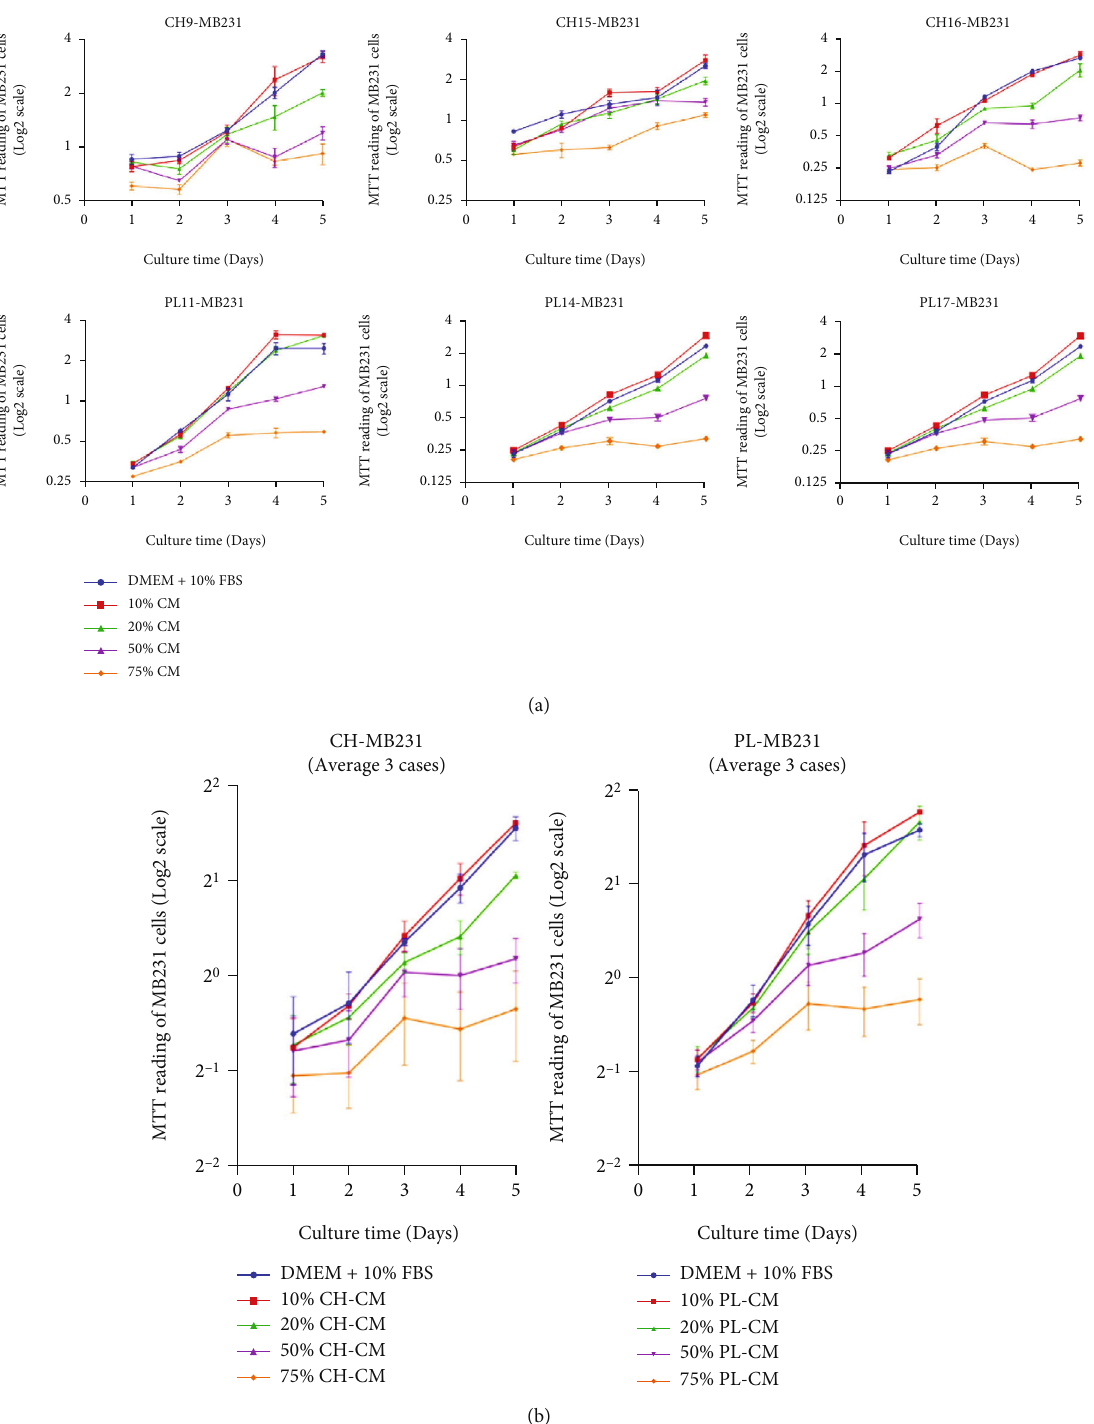
Figure 4: E ff ect of soluble factor derived from CH-hMSCs and PL-hMSCs on the proliferation of human breast cancer MDA-MB231 cells. (a) Graphs show the growth kinetics of MDA-MB231 cells cultured in 10%, 25%, 50%, and 75% conditioned medium derived from CH- hMSCs (CH-CM) and PL-hMSCs (PL-CM) determined by the MTT assay. Data are presented as mean ± SEM of four experiments. MDA-MB231 cultured in DMEM medium +10% FBS served as controls. CH-CMs were prepared from 3 CH-hMSCs (CH9, CH15, and CH16), and PL-CMs were prepared from 3 PL-hMSCs (PL11, PL14, and PL17). (b) Graphs show the growth kinetics of MDA-MB231 cells cultured in 10%, 25%, 50%, and 75% CH-CM (average from CH9, CH15, to CH16) and PL-CM (average from PL11, PL14, to PL17). Data are presented as mean ± SEM of three hMSC-CMs. MDA-MB231 cultured in DMEM medium +10% FBS served as controls. ∗ P < 0 : 05 vs.